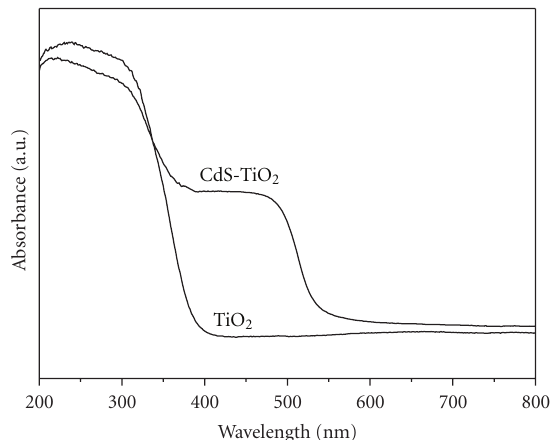
Figure 4: PL spectra of CdS-TiO 2 and TiO 2 samples with the excita- tion wavelength of 360 nm.